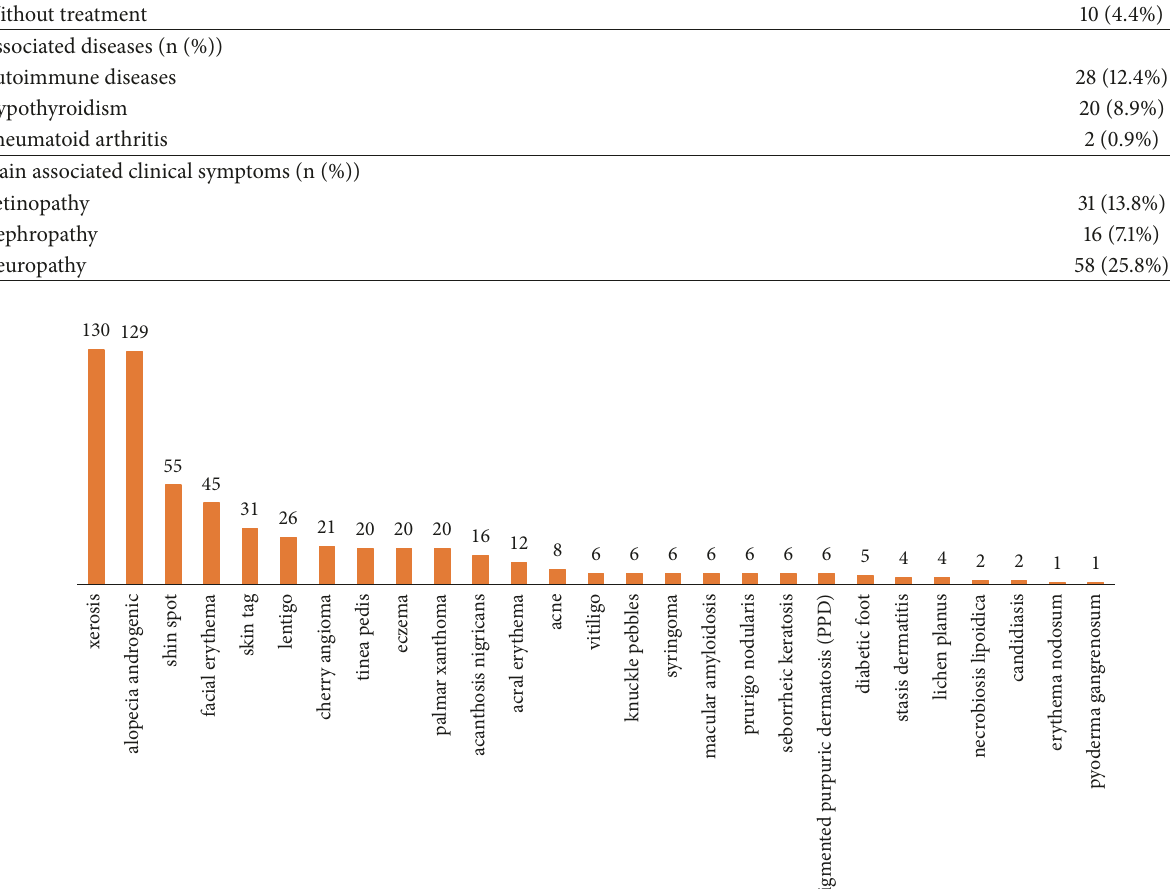
Figure 1: Cutaneous and nail manifestations in studied diabetic patients in the research in terms of the prevalence rate.